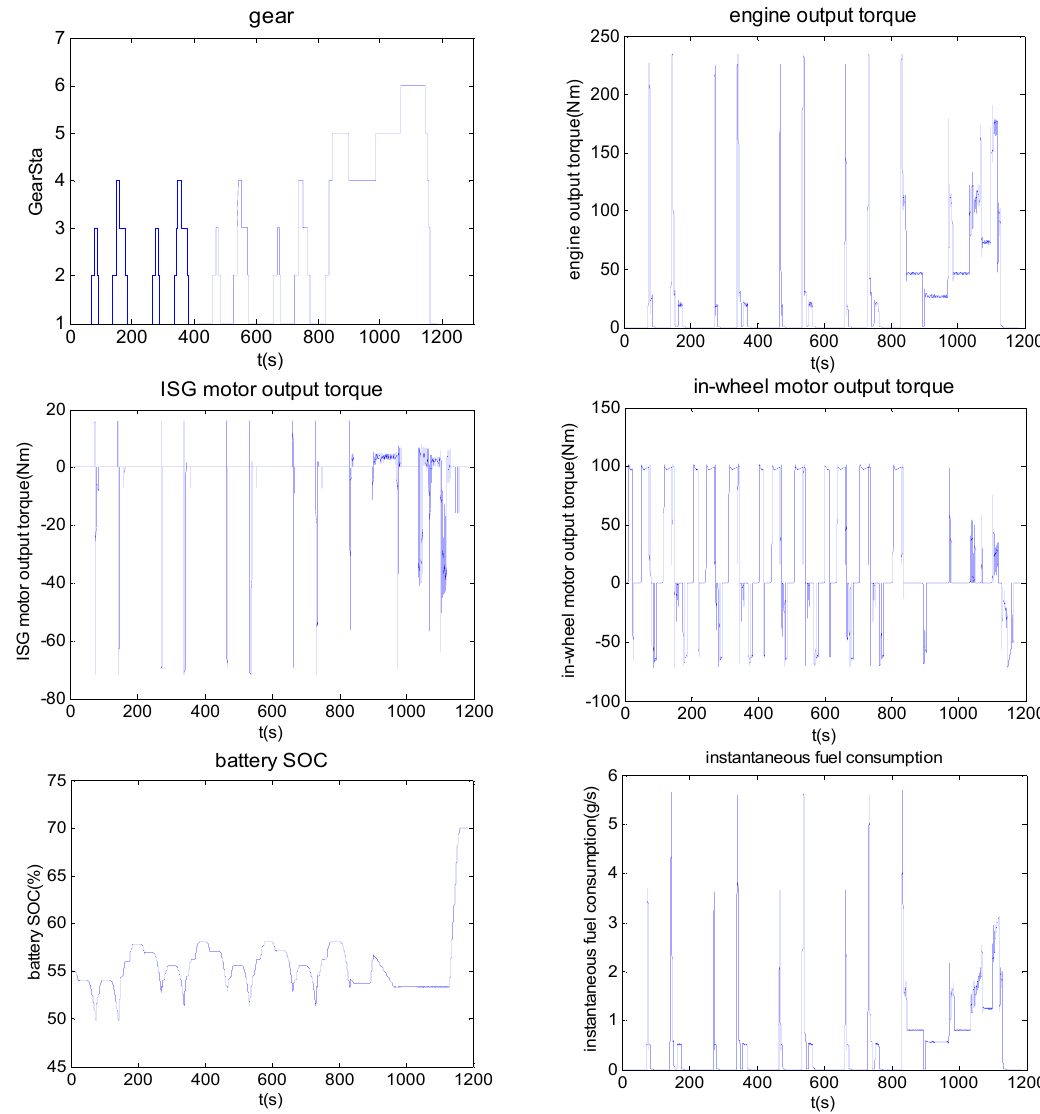
Figure 22. Simulation results of all-wheel drive HEV model utilizing the optimized parameters.